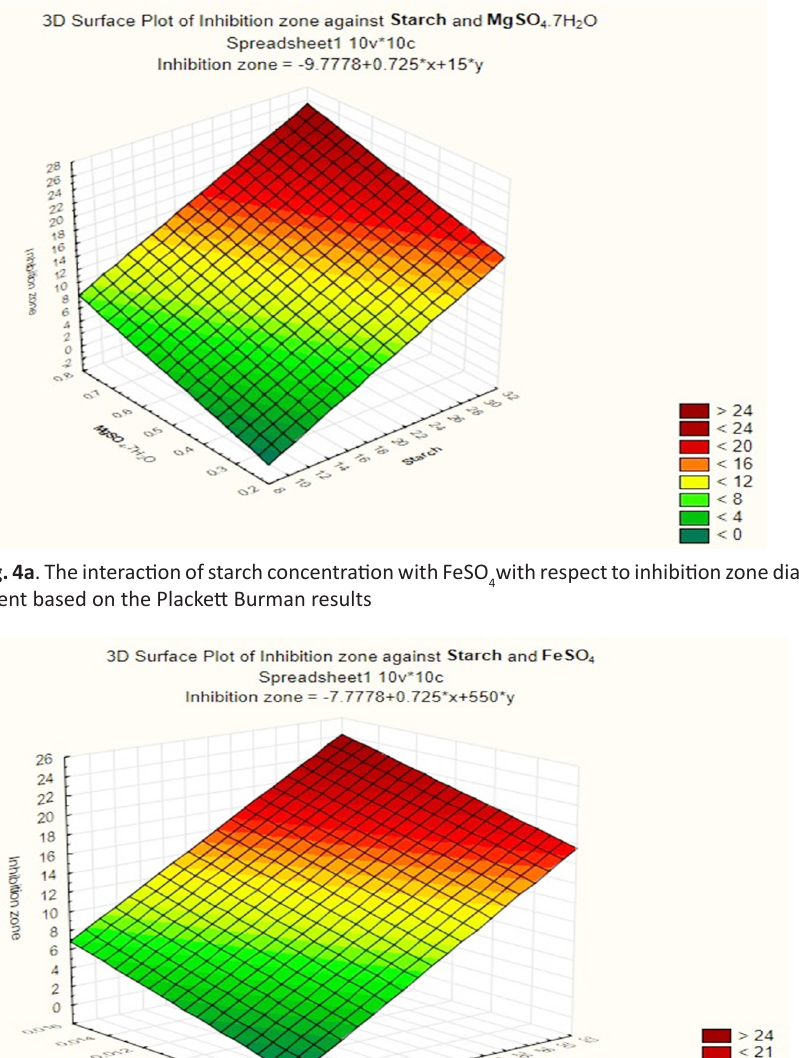
Fig. 4b . The interaction of starch concentration with MgSO antimicrobial agent based on the Plackett Burman